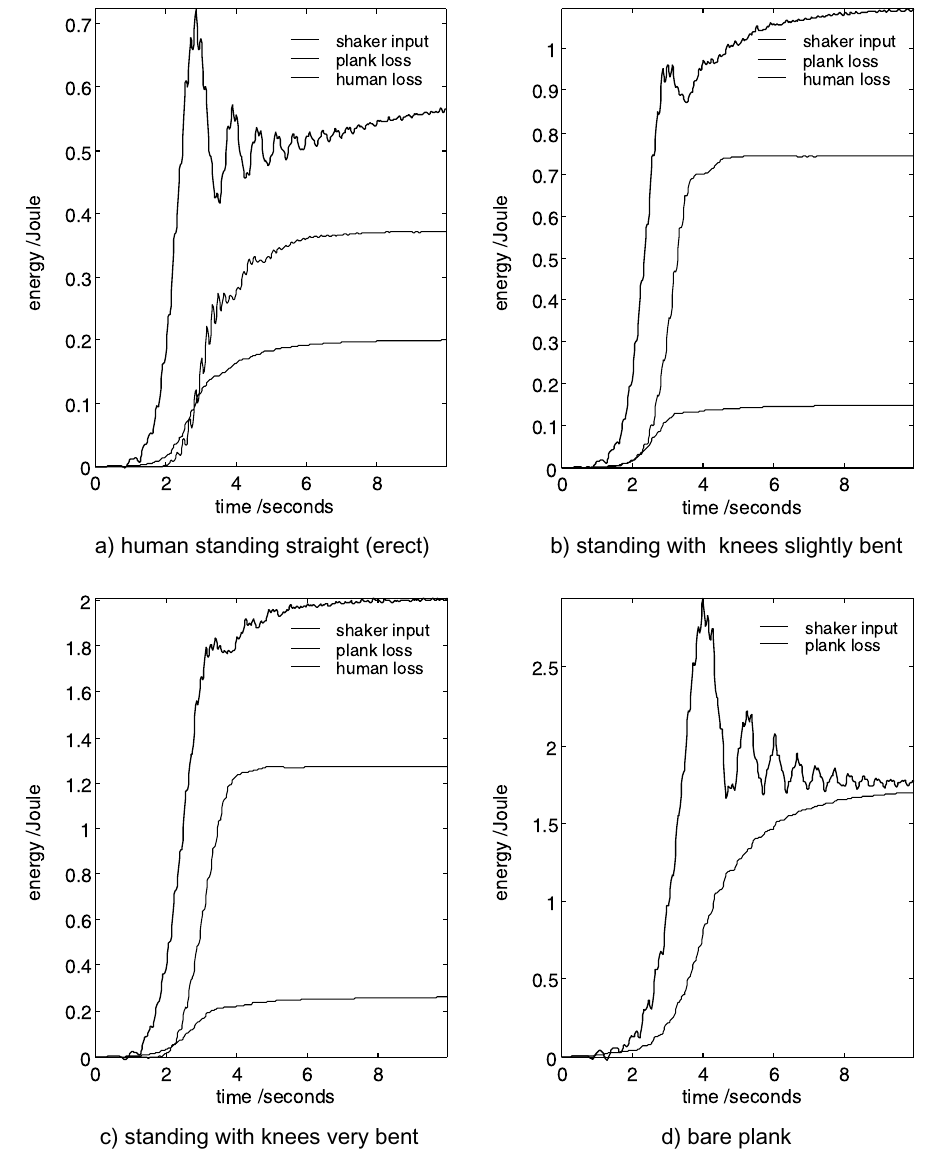
Fig. 5. Energy balance for plank during first 10 seconds of chirp excitation passing through first resonance. a) human standing straight (erect), b) standing with knees slightly bent, c) standing with knees very bent, d) bare plank. f = 2 . 93 Hz and ξ = 2 . 2% plank plank for the mode where the plank vibration dominates, = 5 . 32 Hz and ξ = 36% f human human for the mode where human response is